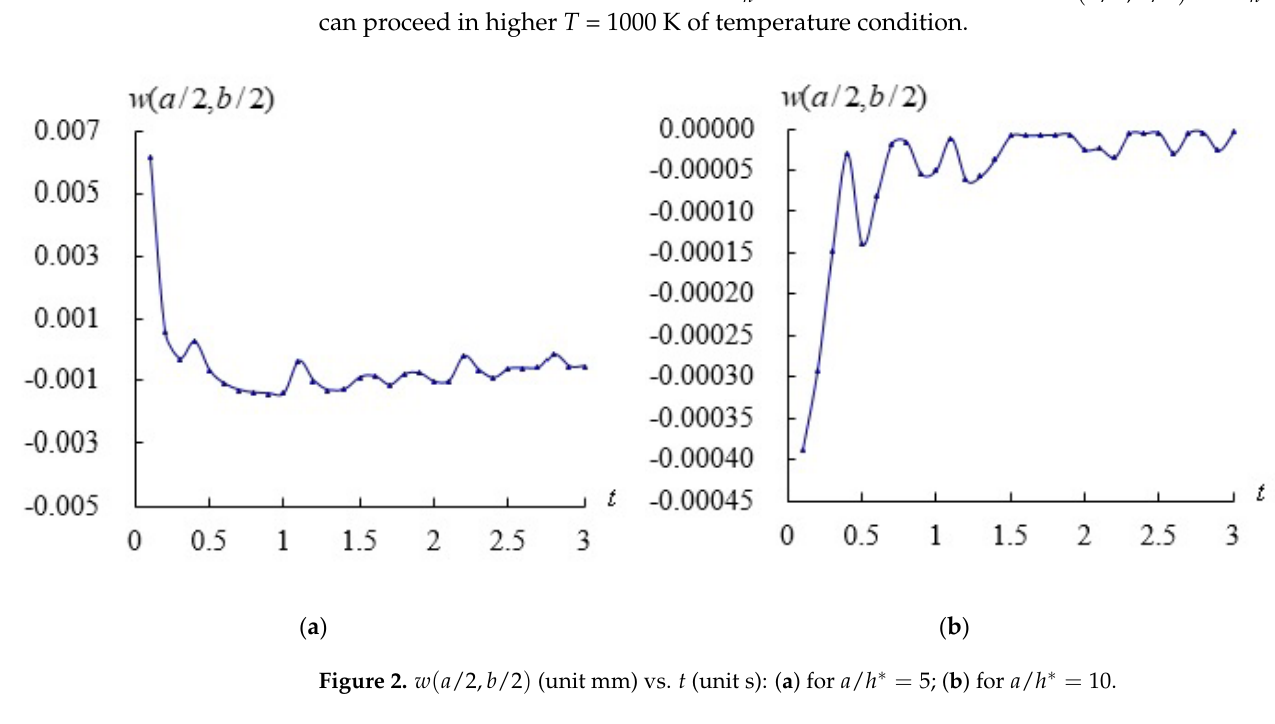
Figure 2. Figure 2. w ( a /2, b /2 ) (unit mm) vs. t (unit s): ( a ) for a / h ∗ = 5; ( b ) for a / h ∗ = 10.